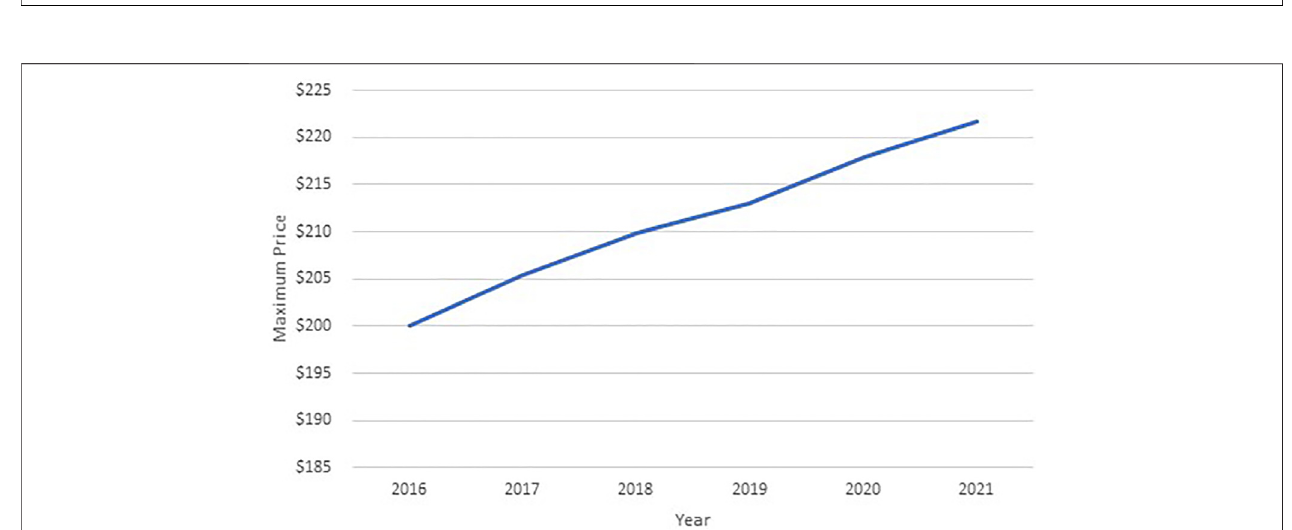
FIGURE 4 | Average price for a credit under California LCFS (CARB, 2021b).